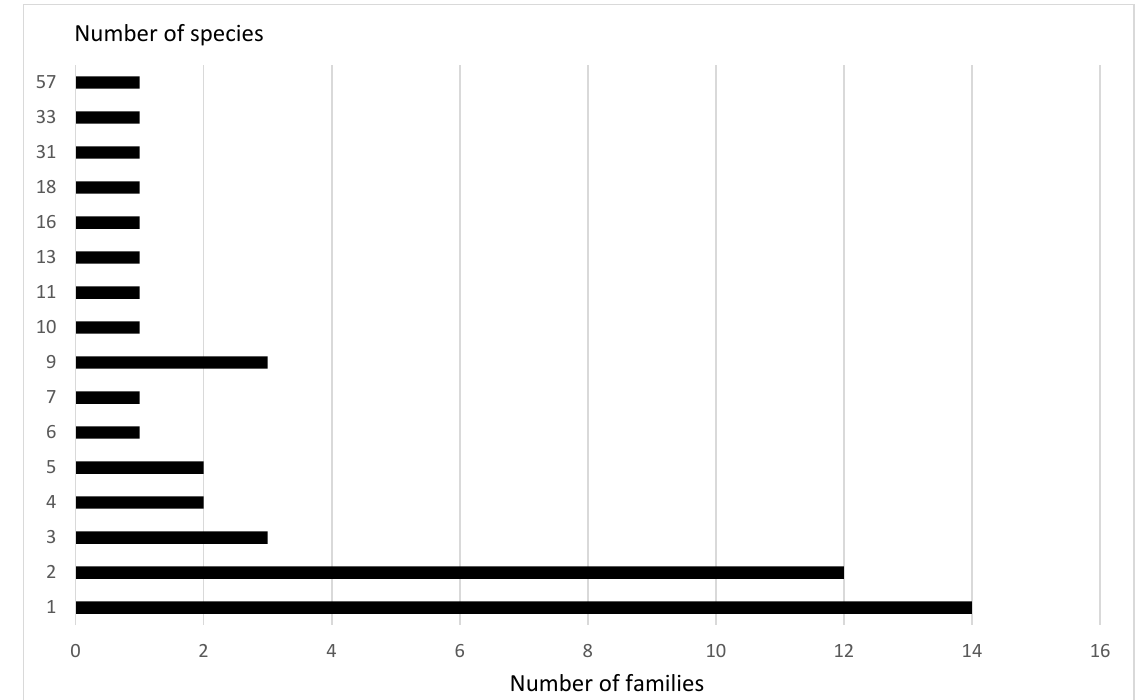
Figure 1. Distribution of the families by the number of captured species in the beer traps.